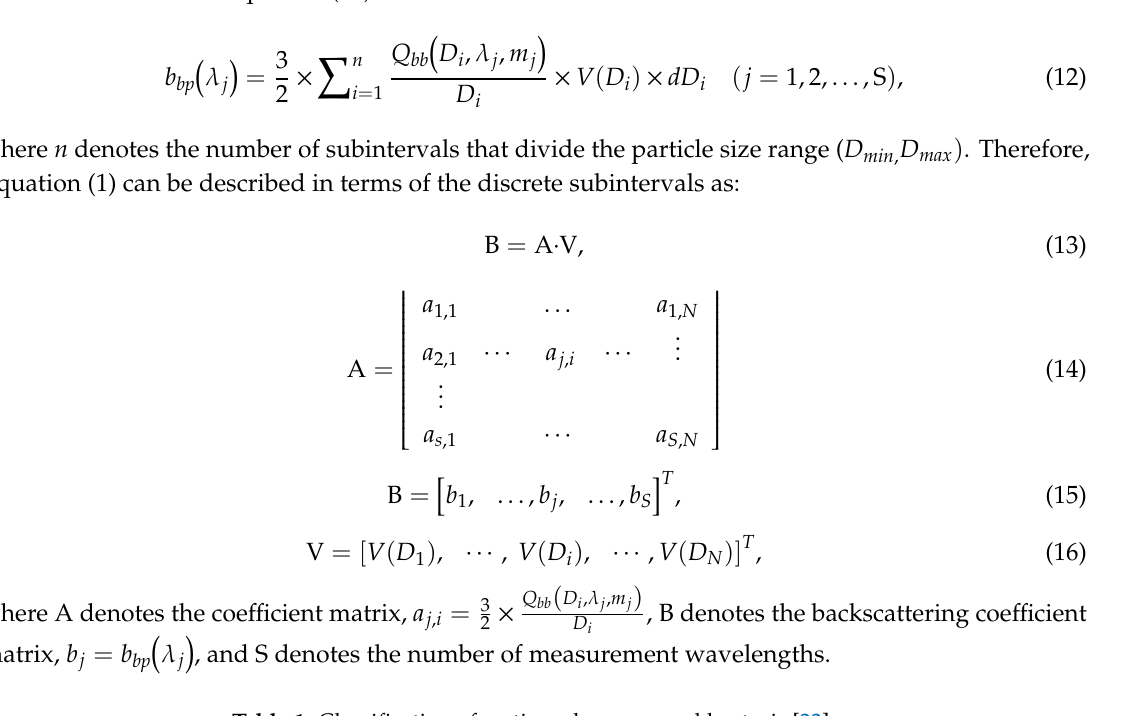
Table 1. Classification of sorting, skewness and kurtosis